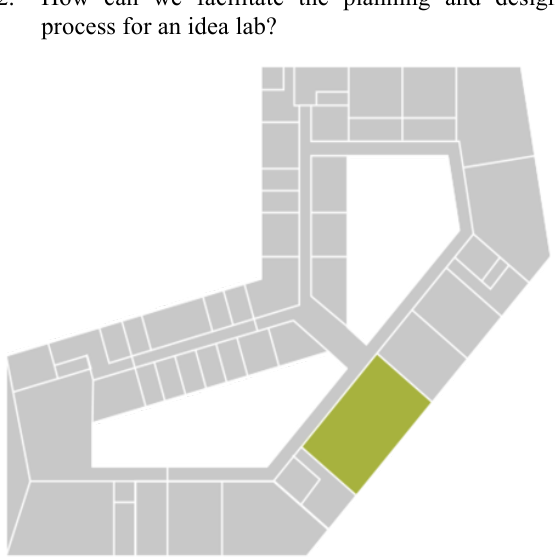
Fig. 1. Floor plan of the building, indicating the location of the idea lab within the innovation centre (image used with permission from Science Park